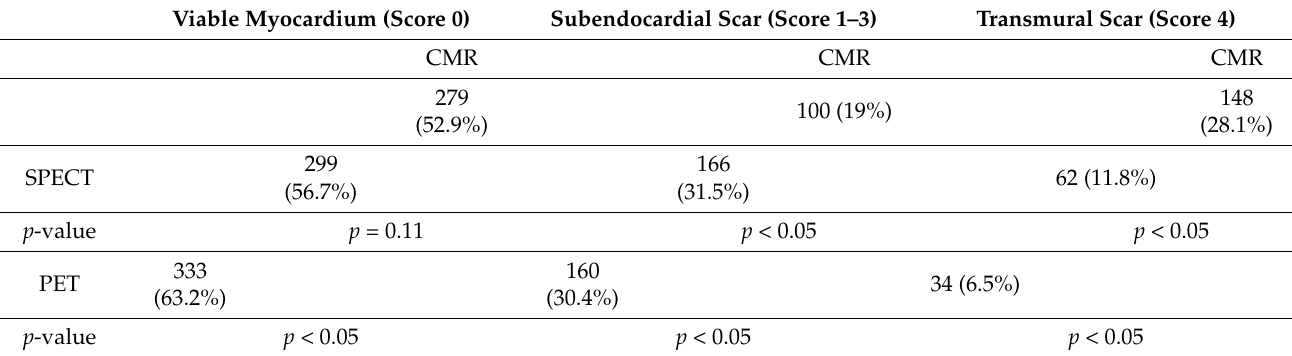
Table 2. Comparative analysis of normal myocardial segments, subendocardial scar segments, and transmural scar segments between different imaging modalities (n = 527).